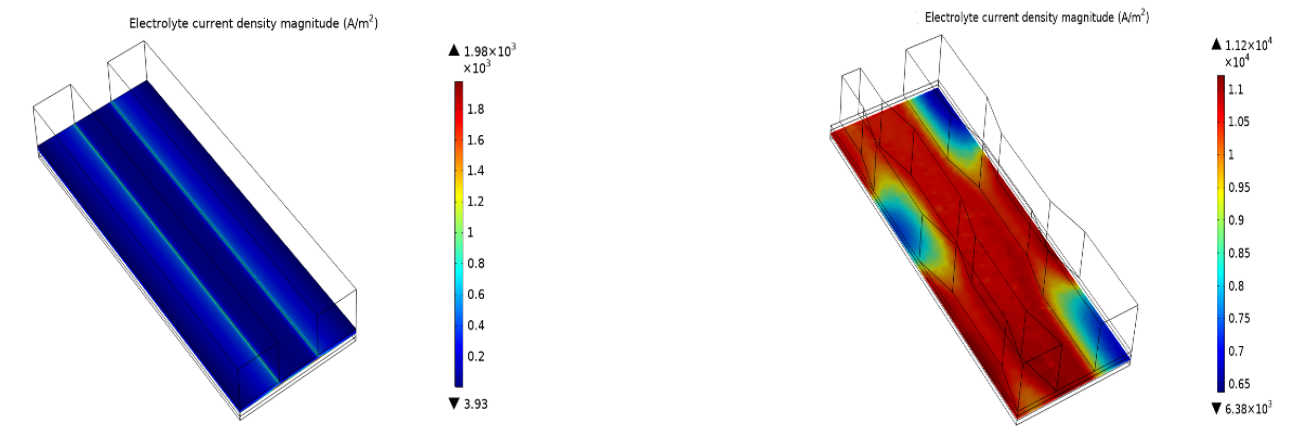
Figure 6. Current density distribution in the conventional channel and the novel channel.